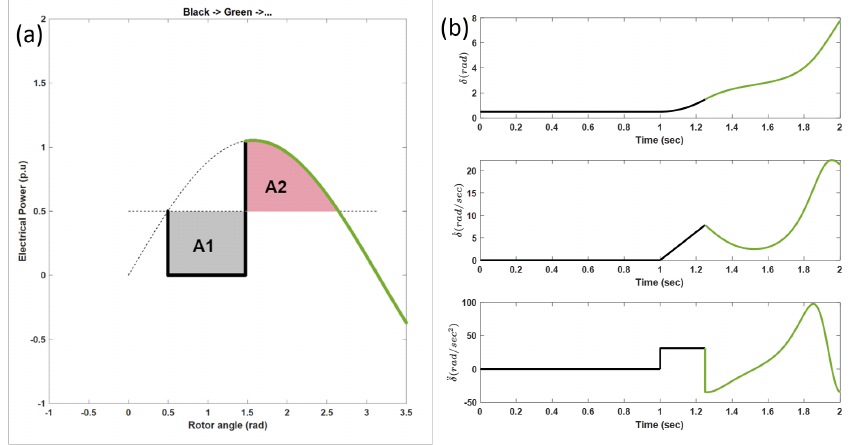
Figure 5. ( a ) Power–angle relationship. ( b ) Angle, speed, and acceleration of the generator after a 15-cycle